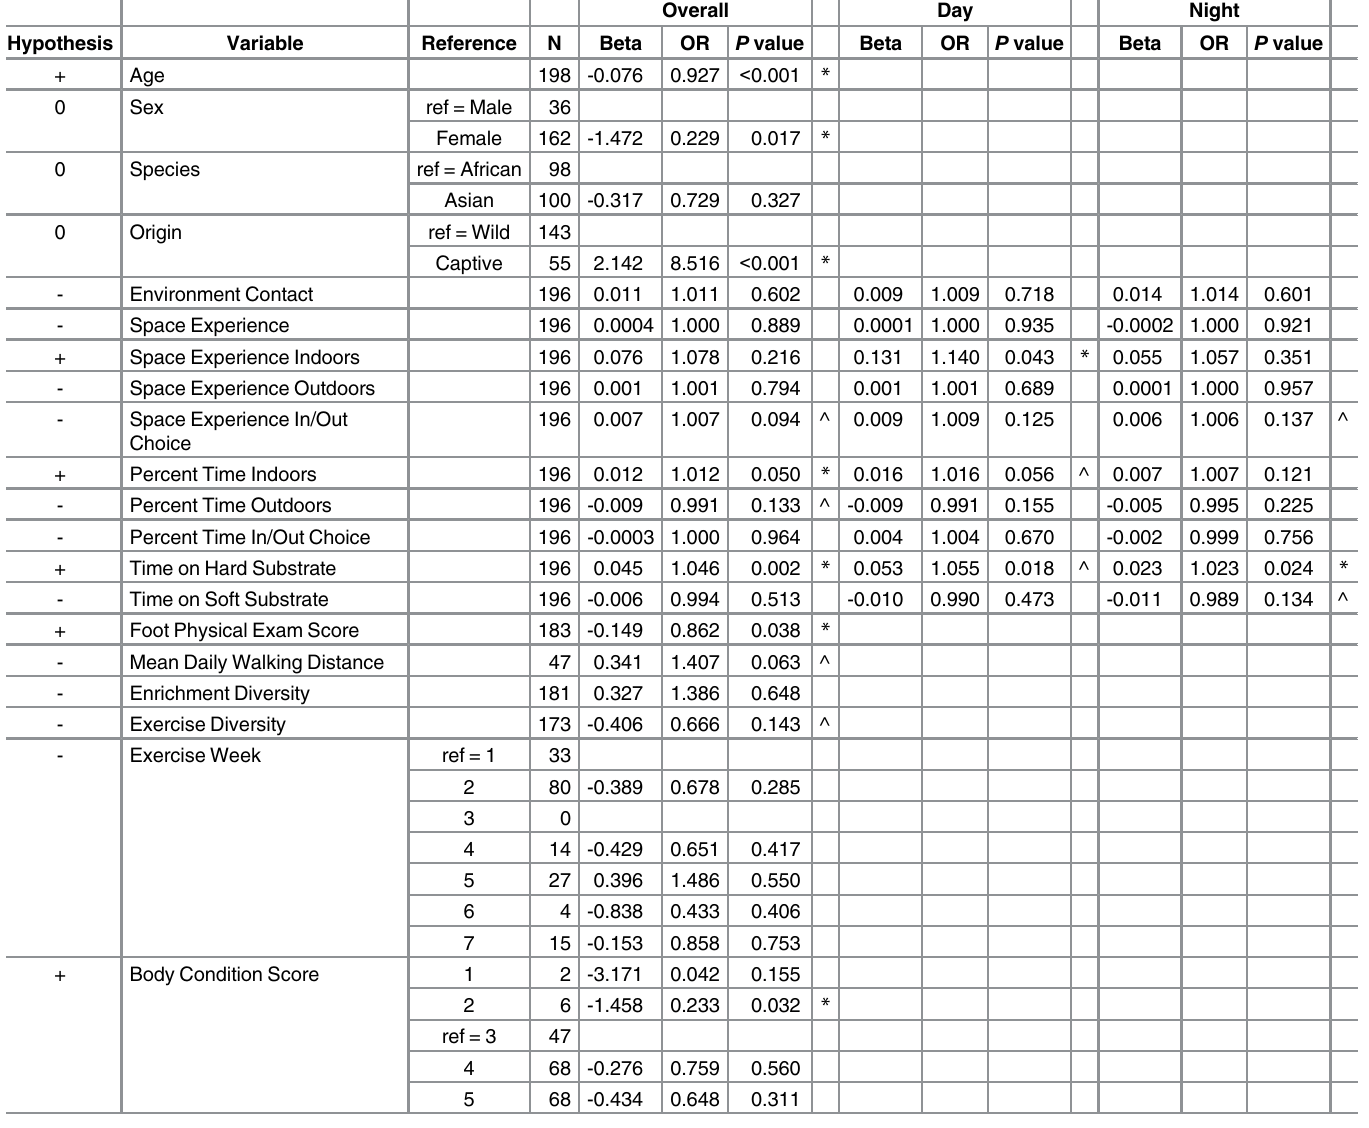
Table 3. Univariate assessment of musculoskeletal (MS) scores in African and Asian elephants using multinomial logistic regression. OR: Odds Ratio; * : P value < 0.05; ^ P value < 0.15 significance threshold for model building. Hypothesis: + Increase odds of having increased MS score; — Decrease odds of having increased MS score; 0 Neutral relationship on MS score.